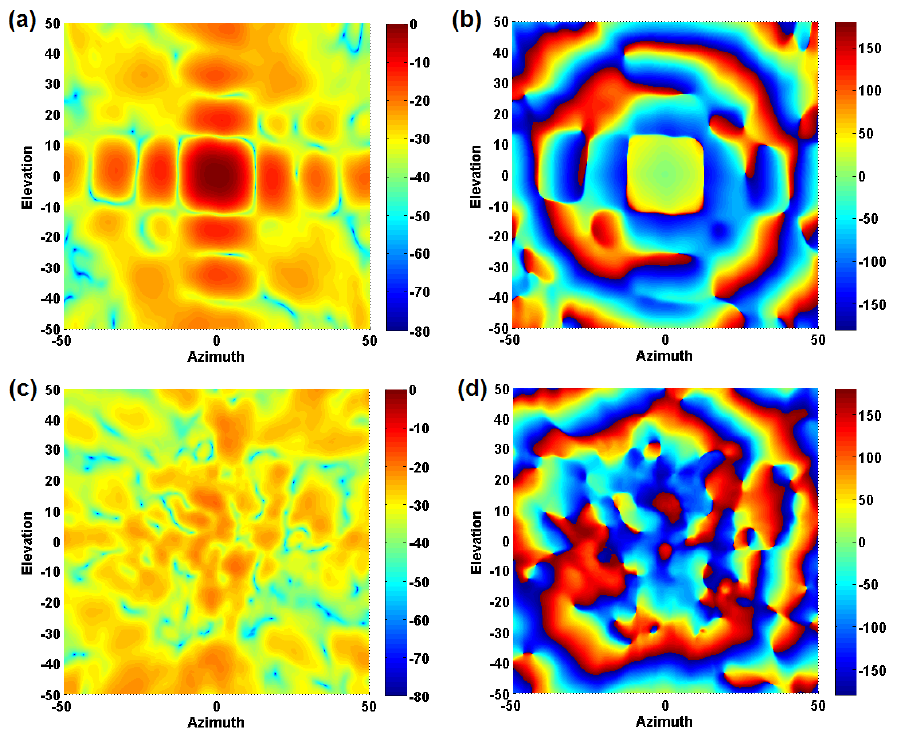
Figure 12. Measured patterns of an eight-by-eight planar phased array antenna (based on AEPs and software calibration) : ( a ) co-polar magnitude in dB; ( b ) co-polar phase in degrees; ( c ) cross-polar magnitude; and ( d ) cross-polar phase in degrees.